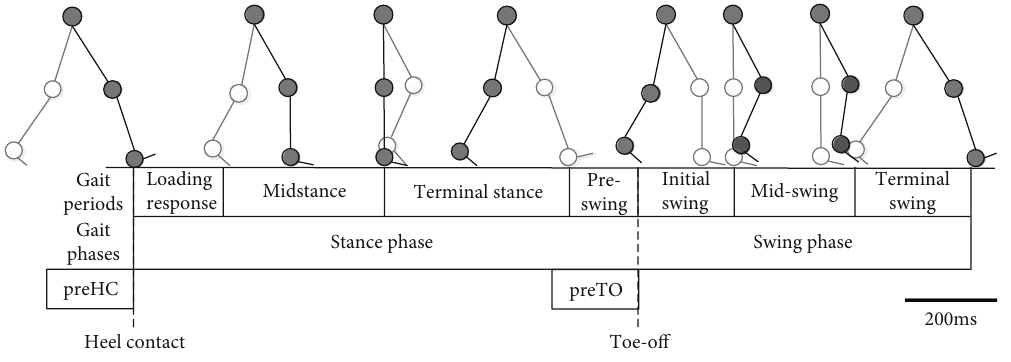
Figure 5: Human gait movement cycle division